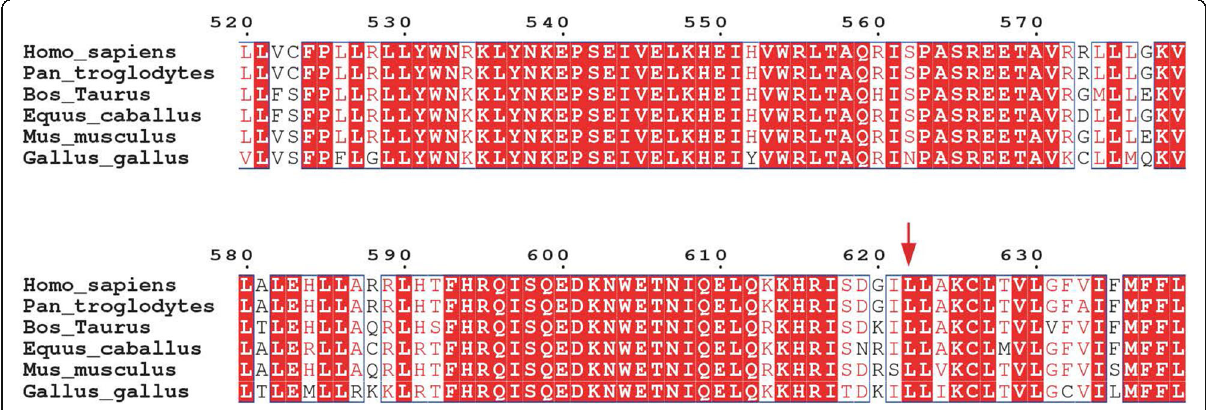
Fig. 1 ClustalW alignment of OCA2 protein among representative species around the sites of